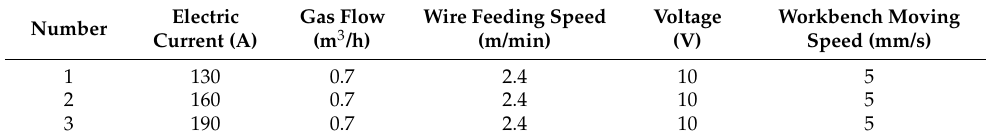
Figure 5. Comparison of parameters and effects. ( a ) The voltage is too large. ( b ) The voltage is 10 V. ( c ) The workbench moves too slowly. ( d ) The workbench moves too fast. ( e ) The gas flow rate is too low. ( f ) The gas flow rate is 0.7 m 3 /h. Table 2. Process parameters.